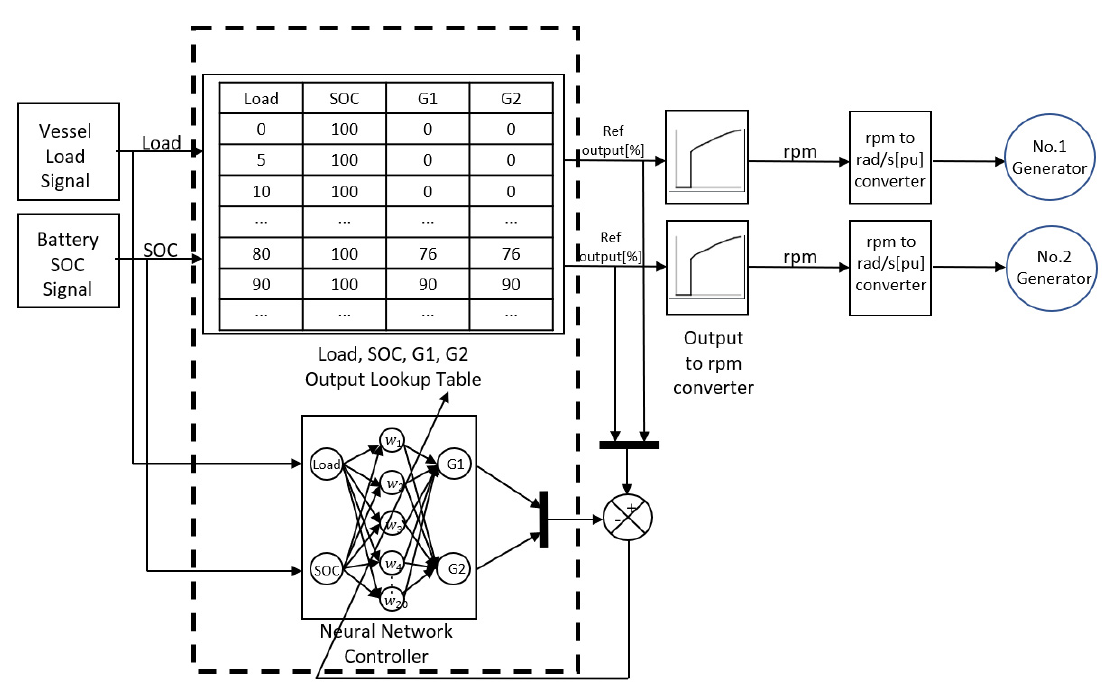
Figure 9. Block diagram of neural network estimator for determining optimal connection.